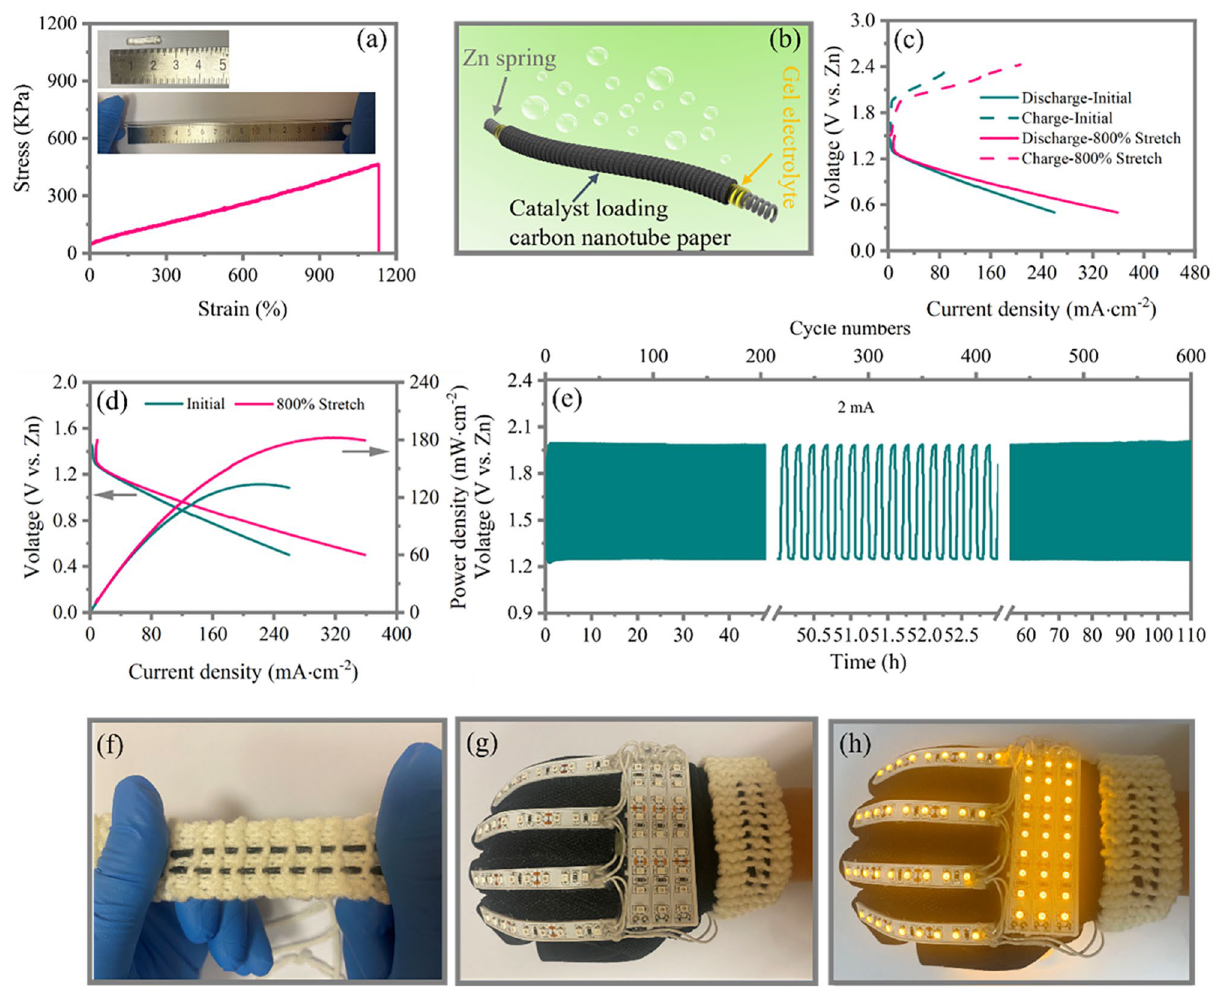
Fig. 4 a Tensile stress versus strain curve of the prepared PANa-cellulose hydrogel with 6 M KOH + 0.2 M Zn(CH 3 COO) 2 intake; the insets are optical photos of the initial and stretched states of this hydrogel electrolyte. b Schematic illustration of stretchable fiber-shaped ZAB. c Galva- nodynamic charge–discharge profiles of fiber-shaped ZAB at initial and 800% stretched states. d Galvanodynamic discharge and corresponding power density curves of fiber-shaped ZAB at initial and 800% stretched states. e Cycling stability test of fiber-shaped ZAB at 2 mA cm −2 ; f Photographs of two fiber-shaped ZABs (length: 10 cm, diameter: 2 mm) woven into a wristband; g Photographs of this wristband connected to a glove. h Photographs of this wristband connected to a glove to power a set of